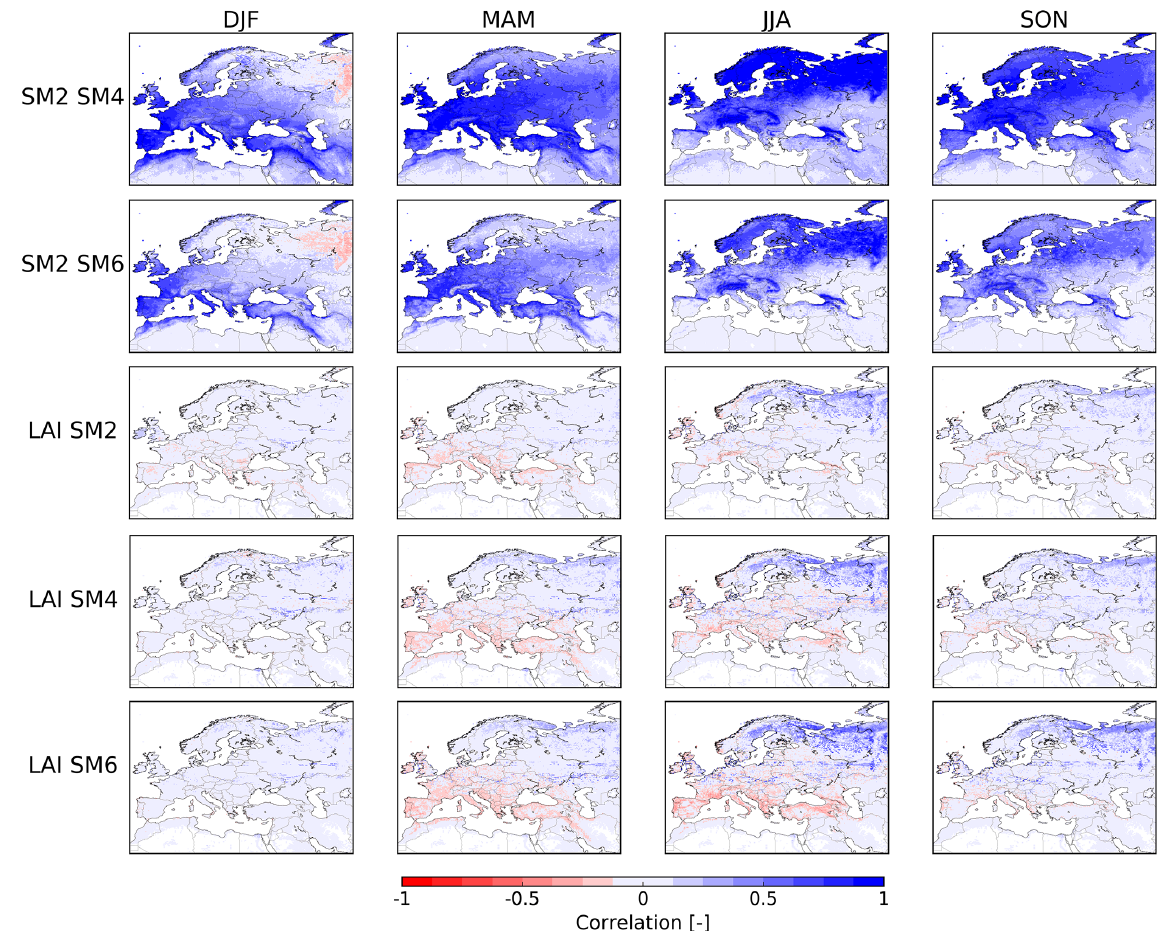
Figure 9. Correlation between the model variables sampled from ensembles and averaged seasonally (DJF: December–January–February, MAM: March–April–May, JJA: June–July–August and SON: September–October–November). From top to bottom: correlation between soil moisture in the second layer (1–4cm; SM2) and the fourth layer (10–20cm; SM4), between SM2 and soil moisture in the sixth layer (40– 60cm; SM6), between LAI and SM2, between LAI and SM4, and between LAI and SM6. Areas is blue exhibit positive correlations; areas in red exhibit